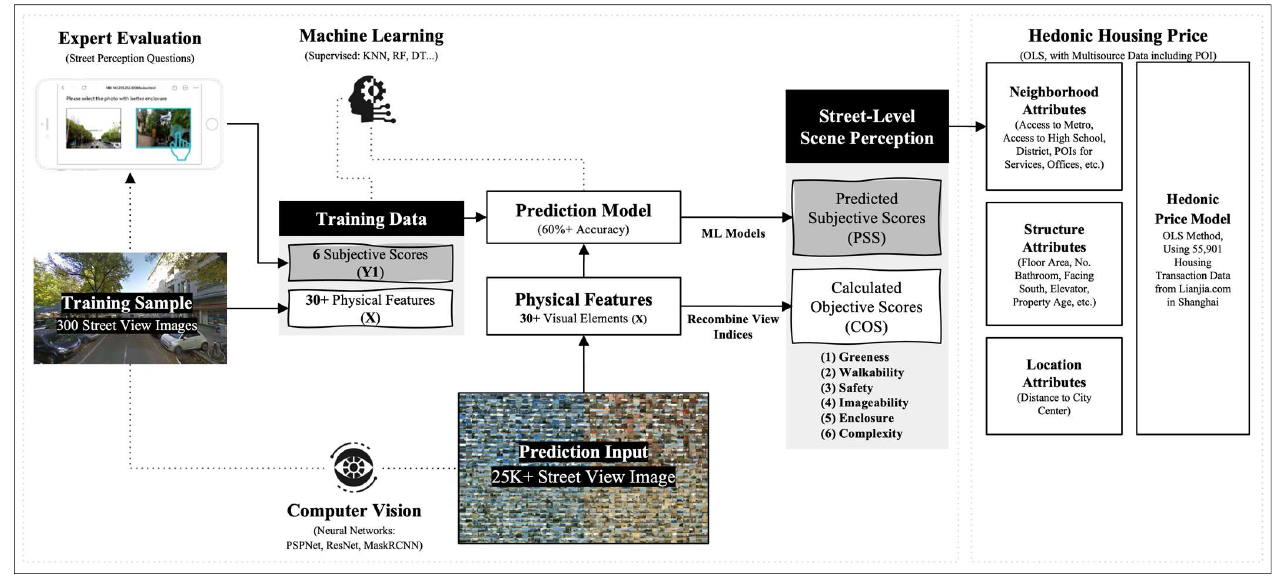
Figure 2. Analytical framework.